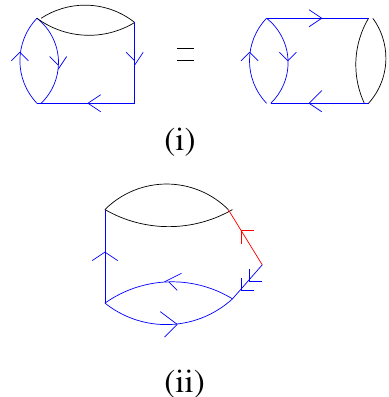
Figure 11 . ( i ) the equal graphs, and ( ii ) the auxiliary